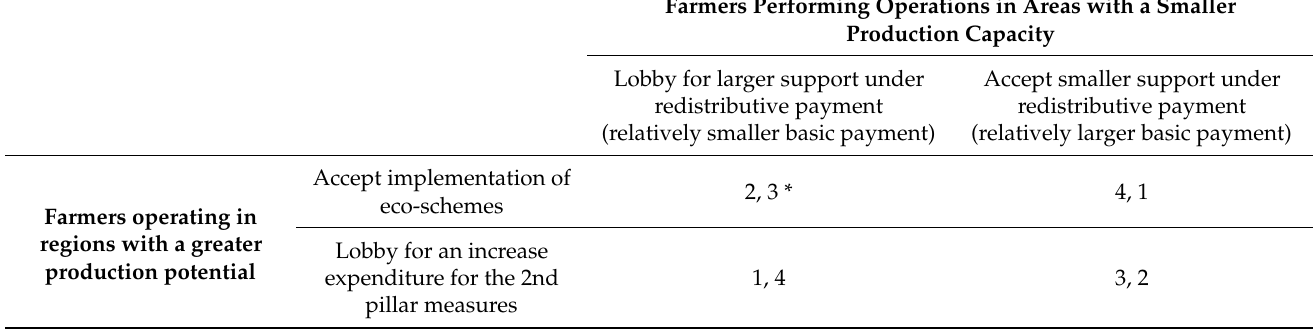
Table 4. Pay-off matrix for the strategic game. Farmers Performing Operations in Areas with a